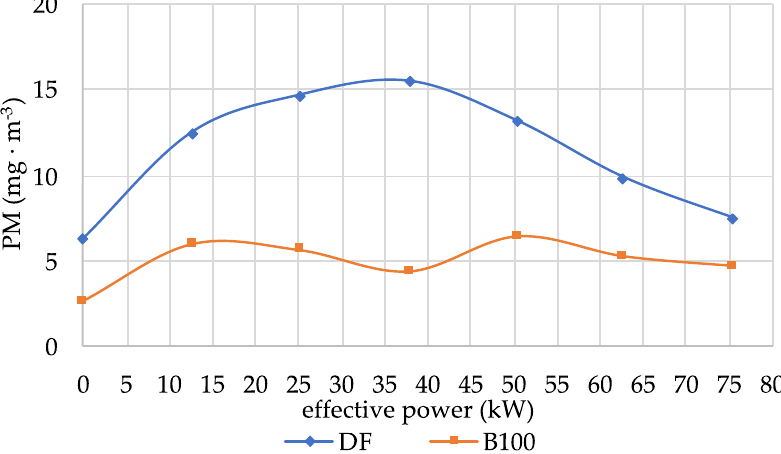
Figure 10. PM emissions vs. the effective power of the John Deere 4045TF285JD engine at 2400 rpm.